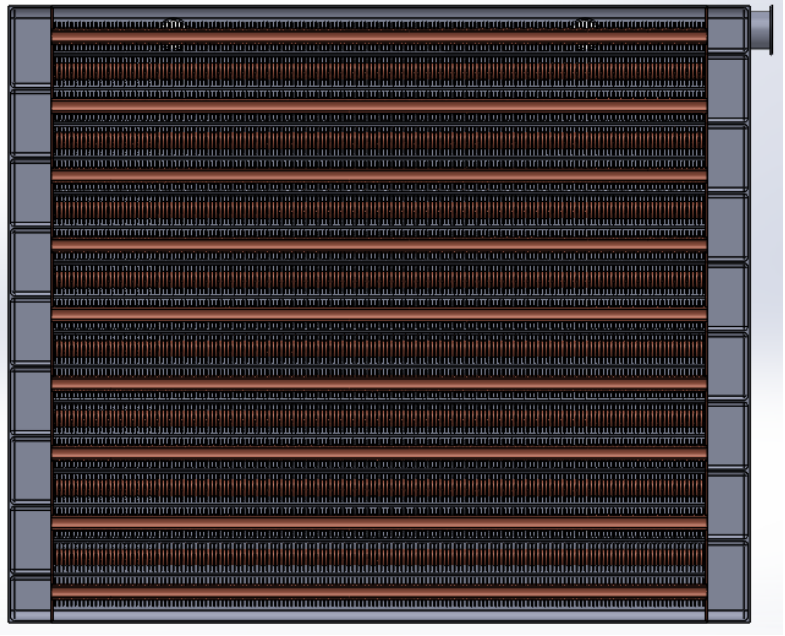
Figure 9. Sectional view of the complete assembly, front view.